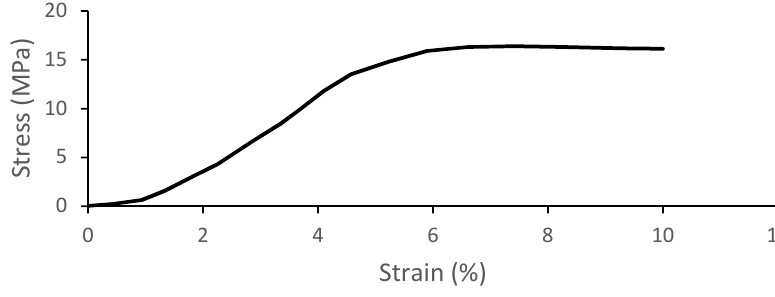
Figure 3. Stress–strain behavior of trabecular bone under compression loading [36].